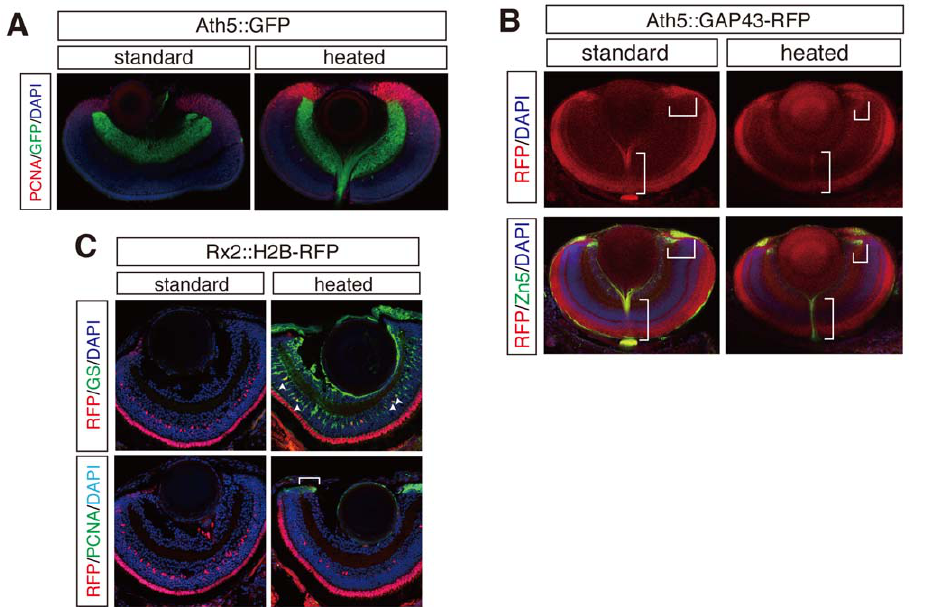
Figure 4. Application of heating method to co-staining with fluorescent proteins (FPs) in transgenic lines. ( A ) PCNA whole-mount immunostaining with Ath5::GFP medaka transgenic line. ( B ) Zn5 whole-mount immunostaining with Ath5::GAP43-RFP zebrafish transgenic line. Note that Zn5 overlaps with RFP-positive optic nerve and retinal progenitor cells (brackets) ( C ) GS and PCNA immunostainings on cryosections of Rx2::H2B- RFP medaka transgenic line. Rx2 dependent H2B-RFP expression clearly co-localizes with GS-positive Mueller glia cells (arrowheads) and PCNA positive retinal progenitor cells in the CMZ (brackets). Nuclei were counterstained with DAPI (blue).